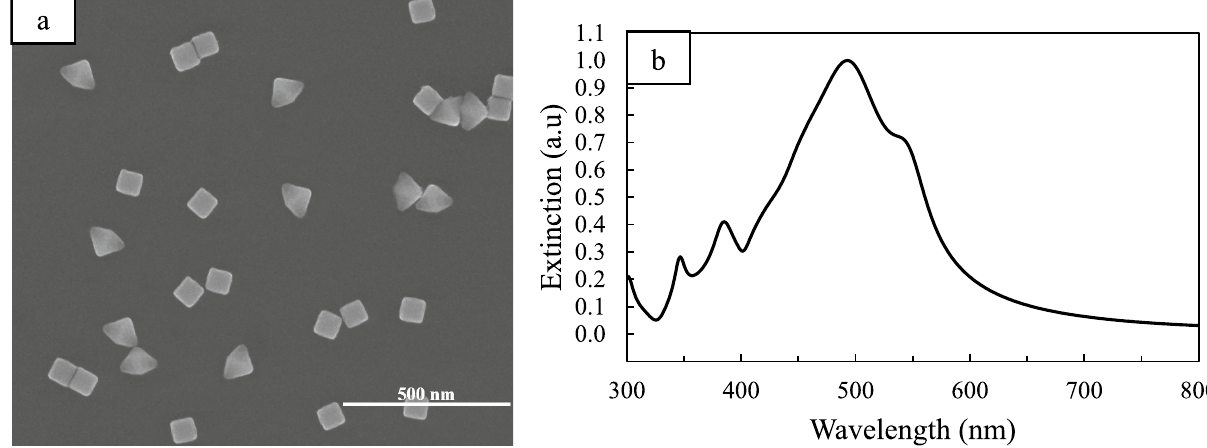
Figure 6. ( a ) SEM image of Ag nanoparticles obtained under irradiance with LED source at 528 nm after 90 min while light intensity is ¼ of normal mode. ( b ) UV–vis spectrum of Ag nanoparticles shown in ( a